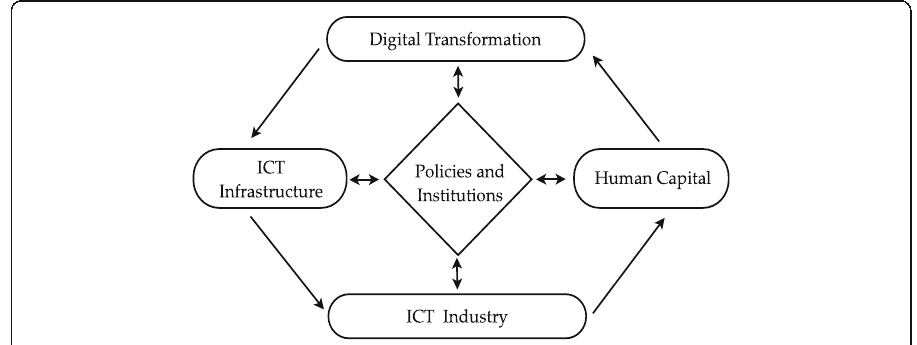
Fig. 1 The digital transformation